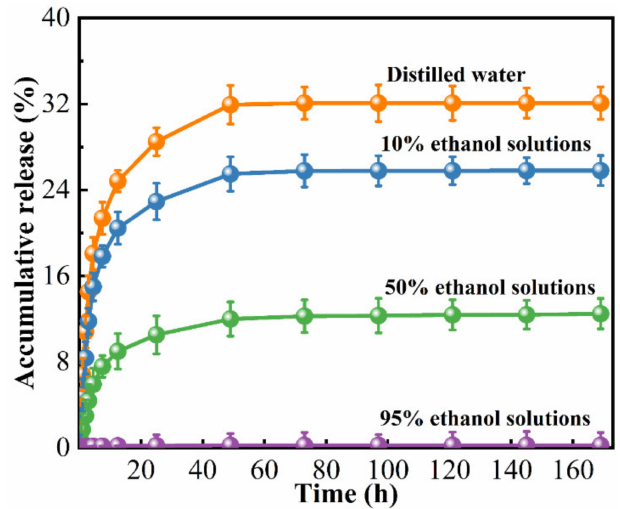
Figure 4. Accumulative release of RCAE from S4 films.